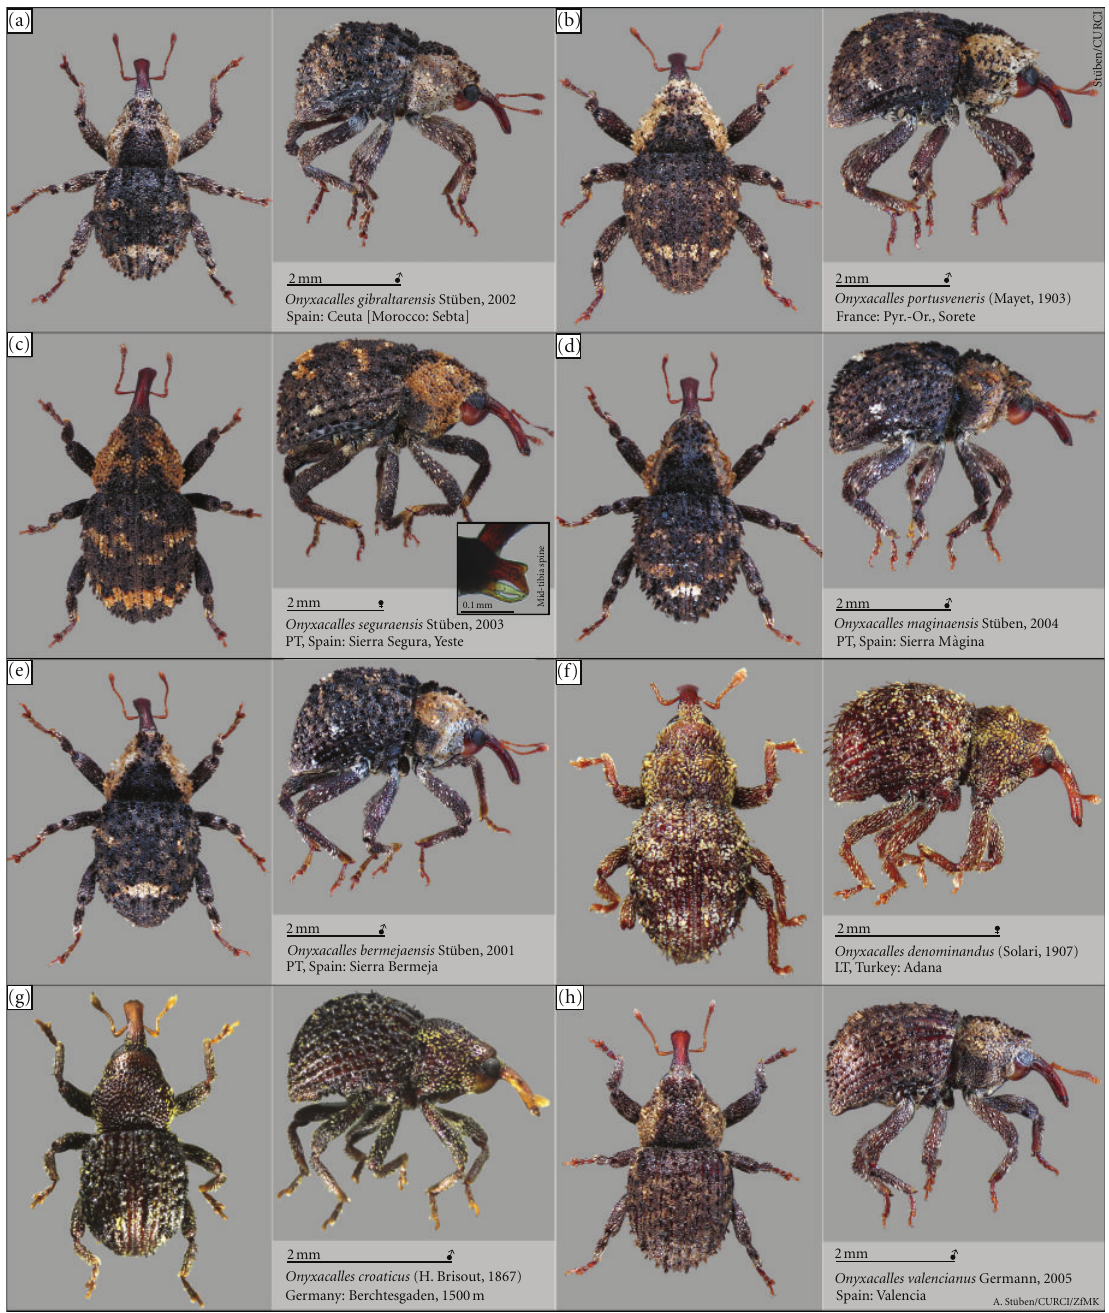
Figure 7: (a–e): Portusveneris group — O. gibraltarensis (a), O . portusveneris (b), O . seguraensis (c), O . maginaensis (d), and O . bermejaensis (e); (f): Incertae sedis — O. denominandus ; (g-h): Henoni group (see also next figures)— O. croaticus (g) and O . valencianus (h) ; all habitus (dor./lat.). densely placed, forming a pronounced tuft at the level of the white fascia. Habitus (Figure 7(e)). Aedeagus (Figure 9(e)). Distribution: Southern Spain (Figure 4). Onyxacalles bermejaensis St¨uben, 2001 Onyxacalles maginaensis St¨uben, 2004 — (9) Pronotum with a deep midgroove and with strong concavities on each side; a species from